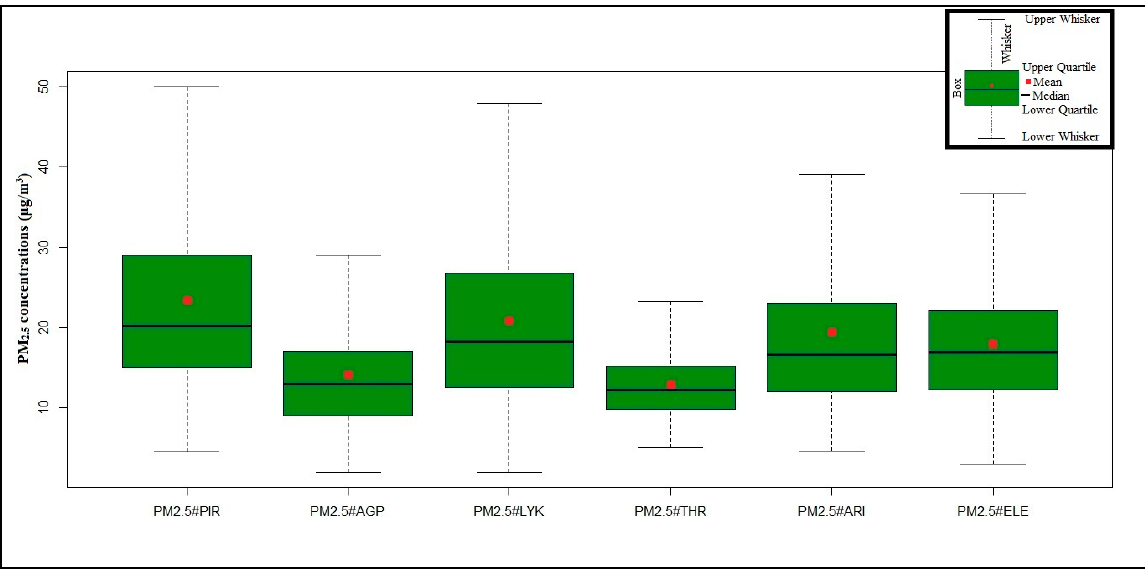
Figure 2. Box and whisker plots with the mean, median and the interquartile range (IQR) of the daily 24 h average concentrations of PM 2.5 at the six AQMS over the study periods.